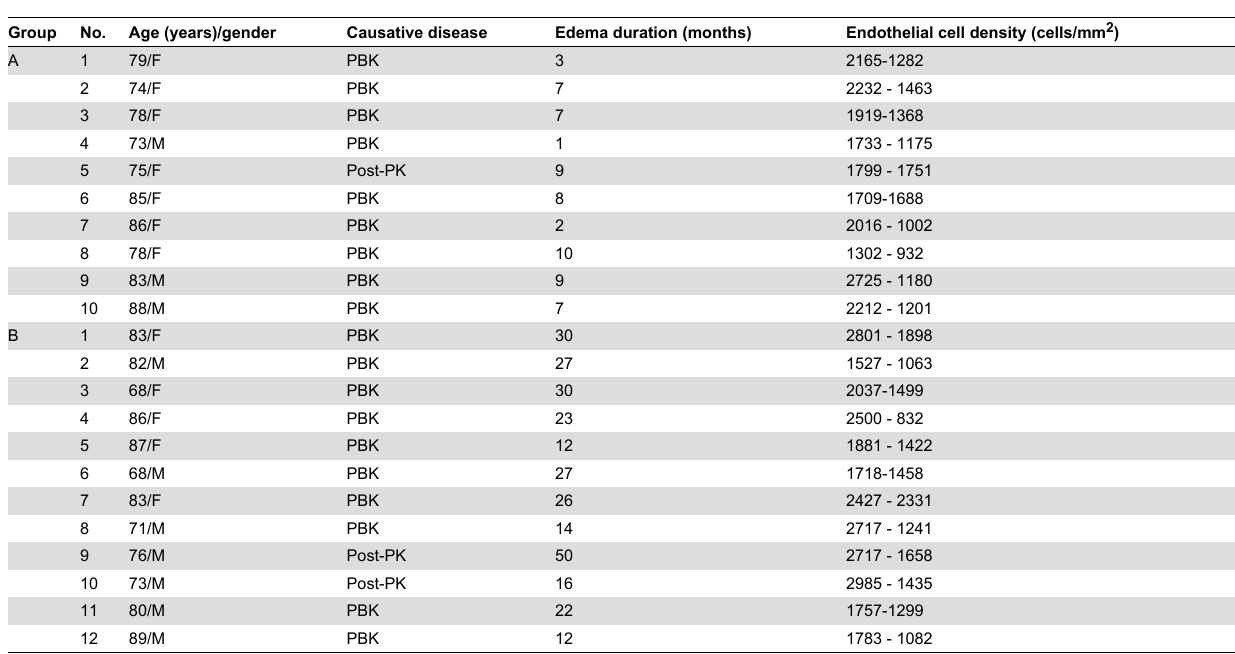
Table 1. Characteristics of the study subjects.